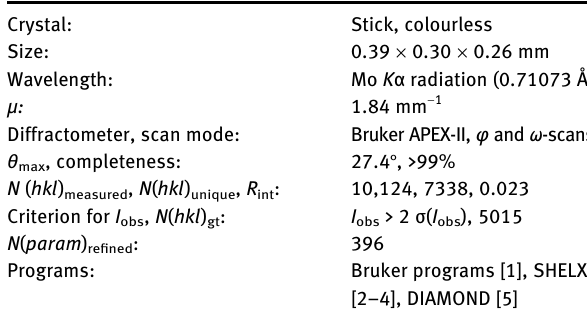
Table  : Data collection and